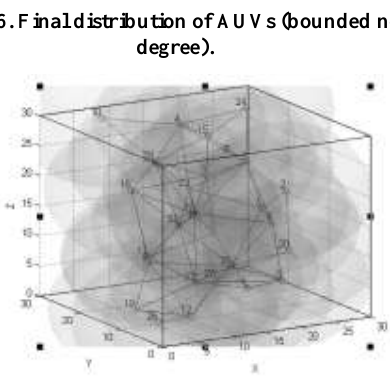
Figure 7. Final distribution of AUVs (unbounded node degree).